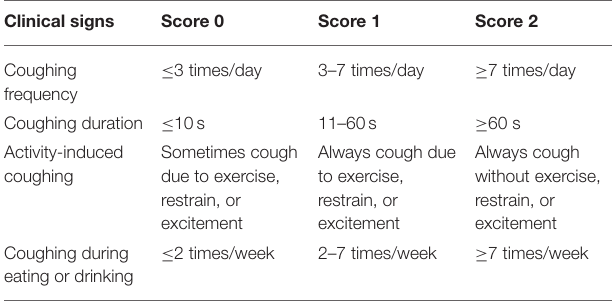
TABLE 1 | Representative questionnaire in rubric scoring system for clinical sign